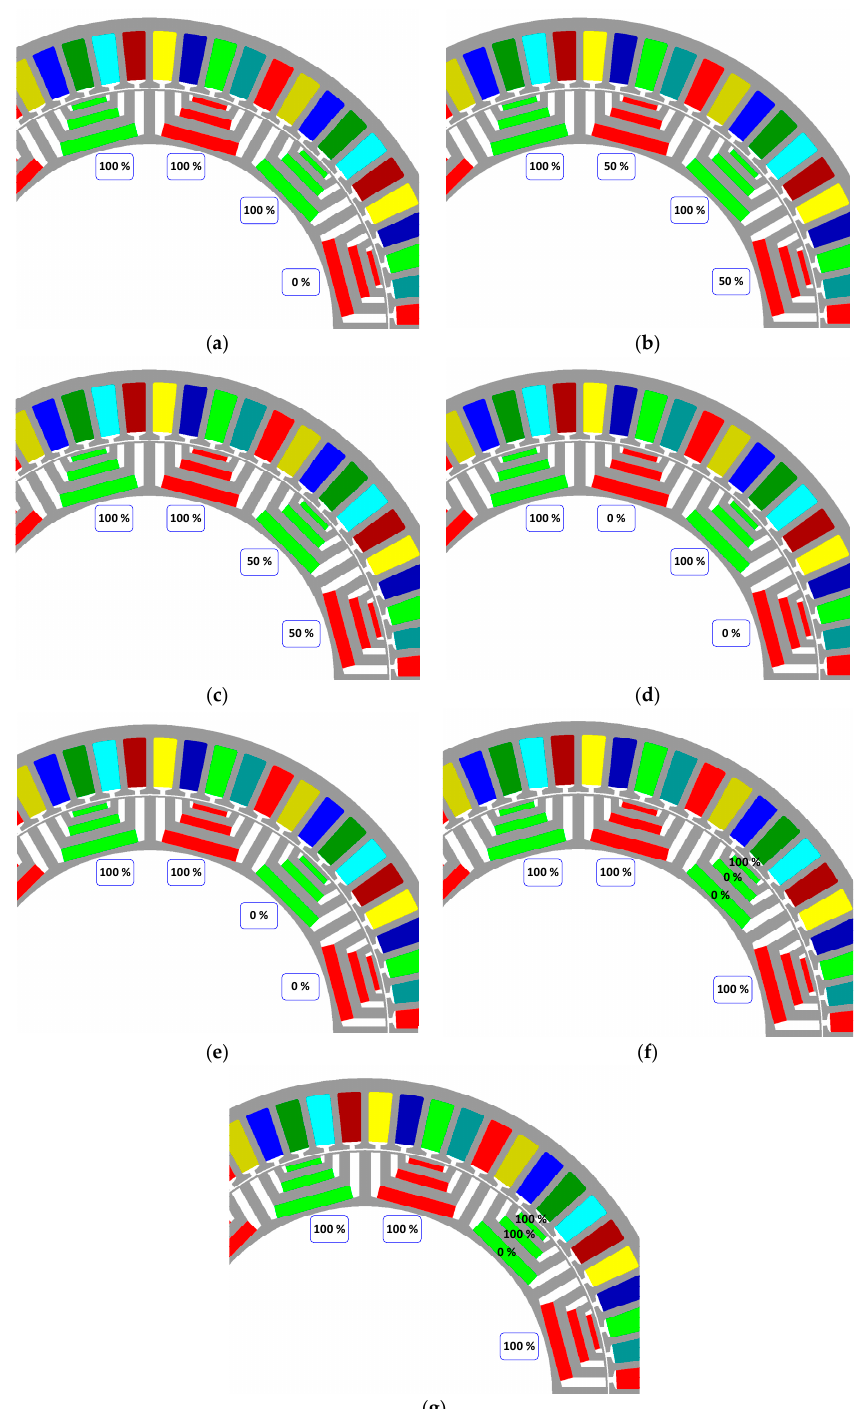
Figure 5. Di ff erent analyzed demagnetization faults underrated speed and applying the maximum i d current ( i q = 0). ( a ) One magnetic pole 100% demagnetized. ( b ) Two adjacent north magnetic poles 50% demagnetized. ( c ) Two adjacent north-south magnetic poles 50% demagnetized. ( d ) Two adjacent north magnetic poles 100% demagnetized. ( e ) Two adjacent north-south magnetic poles 100% demagnetized. ( f ) Two magnets of the same pole 100% demagnetized. ( g ) Only one magnet 100%